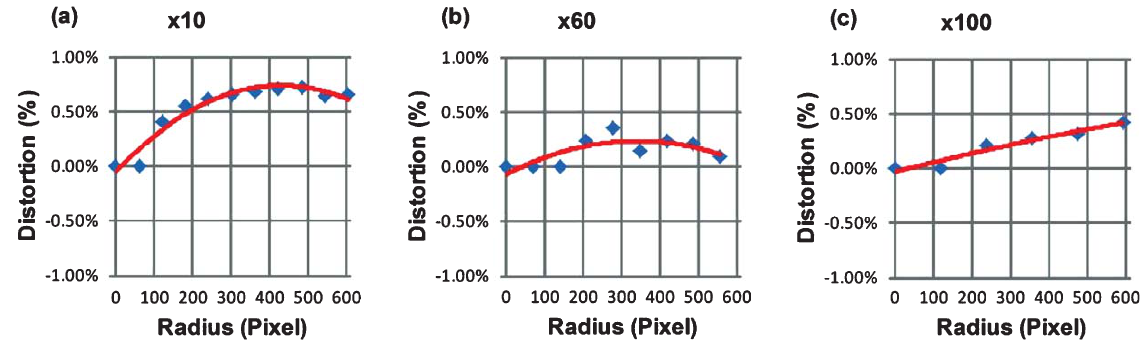
Fig. 4. Distortion profiles of the system under different objective lenses: (a) 10 × /0.45 Nikon Plan Apo λ objective lens. (b) 60 × 60 × /0.95 Nikon Plan Apo λ objective lens. (c) 100 × /1.45 Nikon Plan Apo λ oil-immersion objective